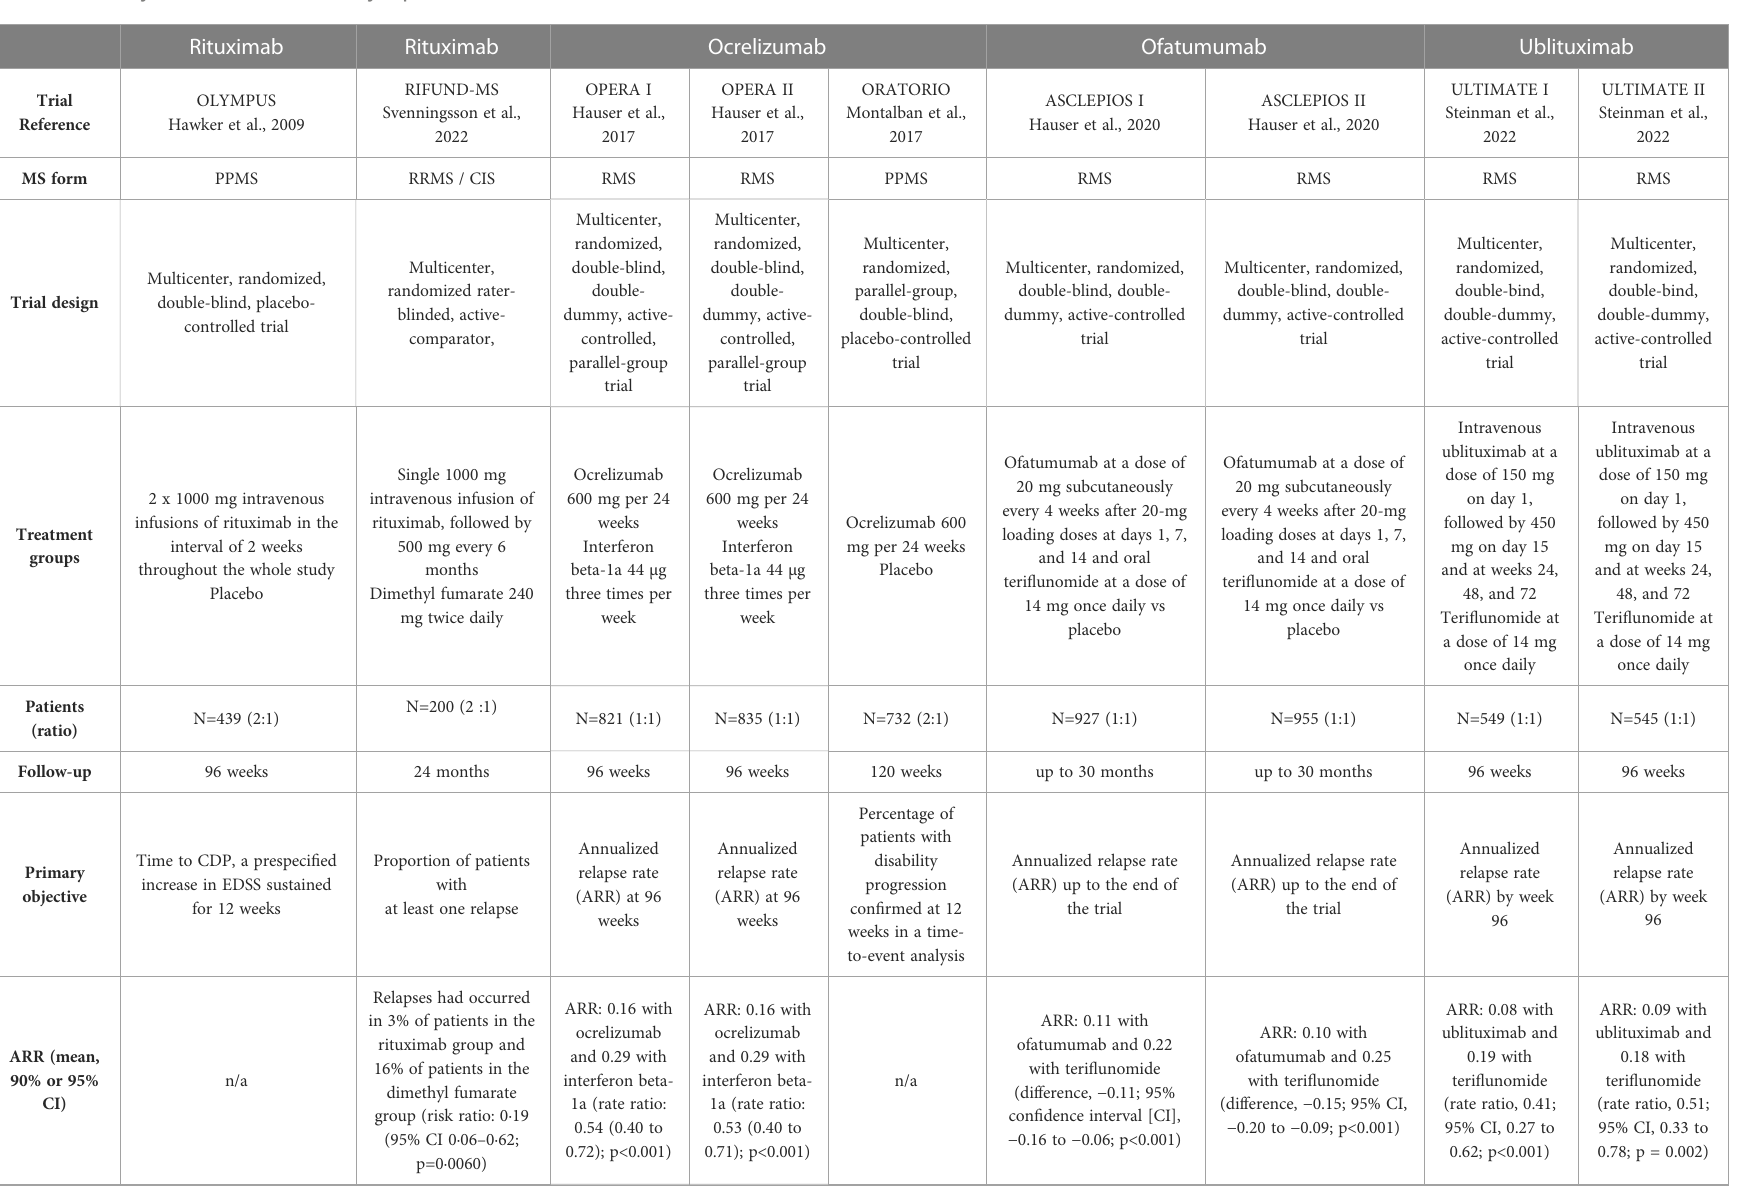
TABLE 3 Summary of clinical and MRI ef fi cacy in phase III clinical